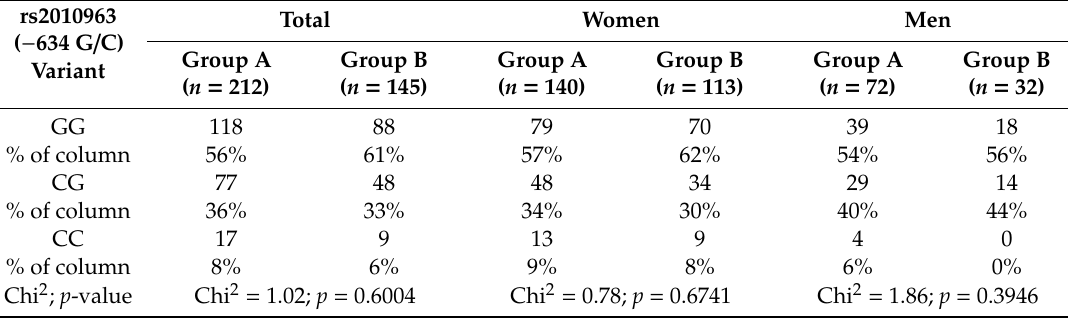
Table 4. Distribution of genotypes of rs2010963 (634 G / C) variant of VEGF